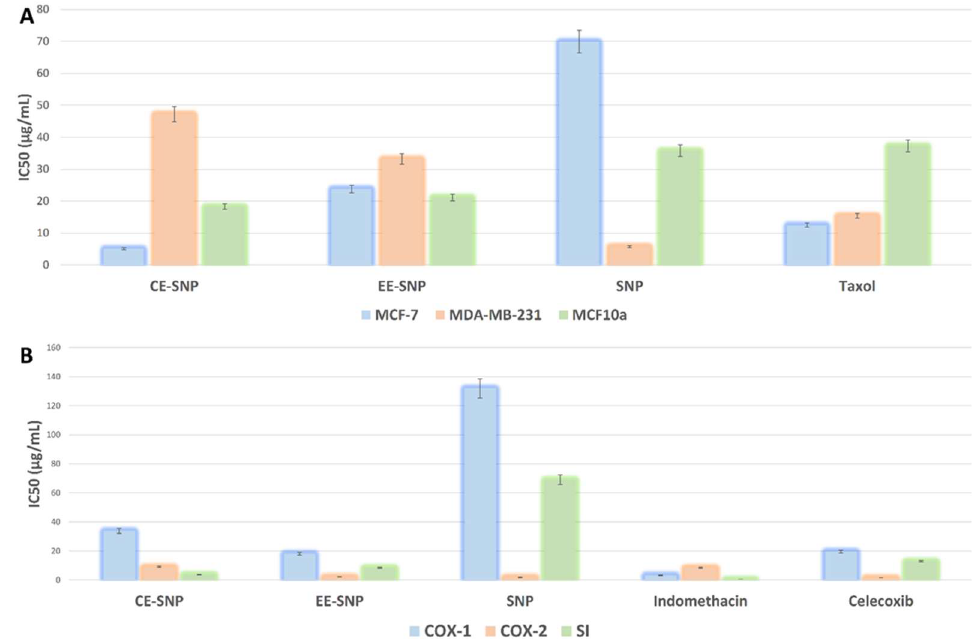
Figure 8. In vitro growth inhibitory activities of the prepared SNPs against estrogen-positive and triple negative breast cancer cell lines alongside a normal breast cell line ( A ), and their inhibitory activities against both COX-1 and COX-2 ( B ). IC 50 values were expressed as µg/mL ± SE. CE-SNP—SNPs loaded with chloroform extract; EE-SNP—SNPs loaded with ethyl acetate extract; SNP—free SNPs; SI—selectivity index.